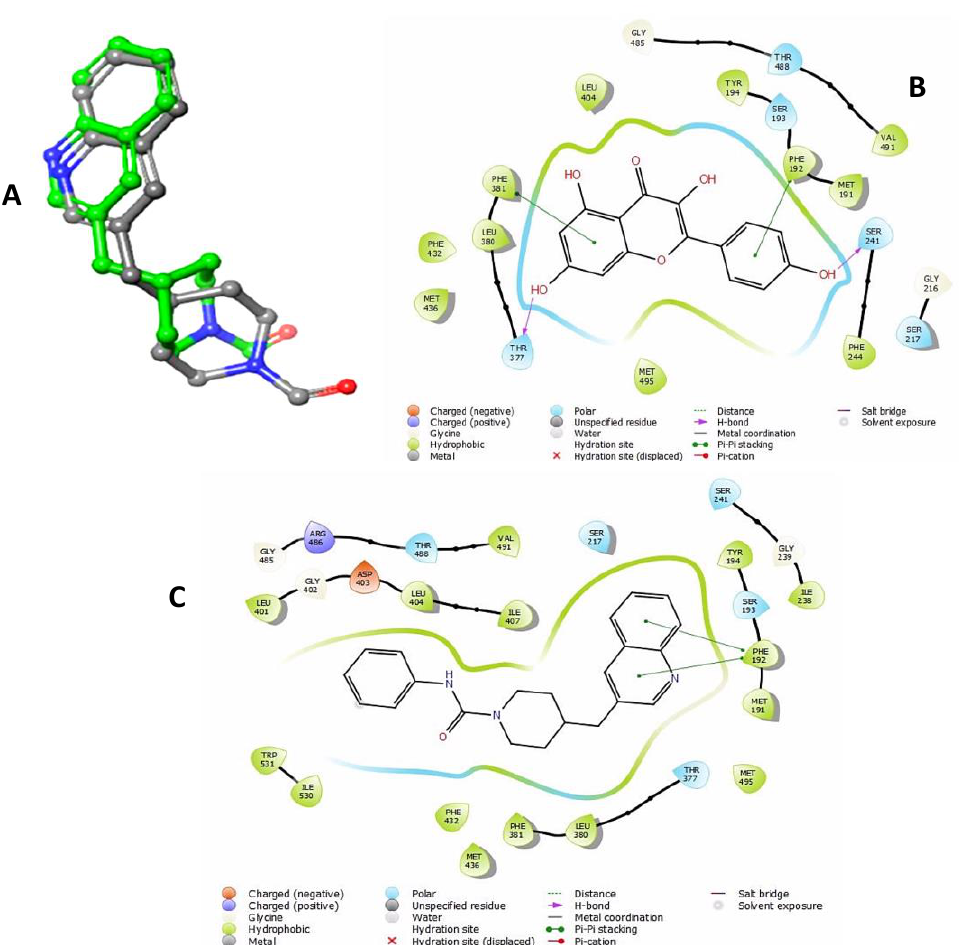
Figure 5. In silico docking analysis of kaempferol. ( A ) Rigid receptor docking (RRD) of the co-crystalized ligand at the active site of FAAH. It shows a cognate re-docked pose (green) of kaempferol compared with co-crystalized pose (elemental). ( B ) Kaempferol interaction with residues of FAAH active site simulated in two-dimensional (2D) plot to visualize the key interacting residues. ( C ) PF-750 interaction with residues of FAAH active site simulated in 2D plot to visualize the key interacting residues.